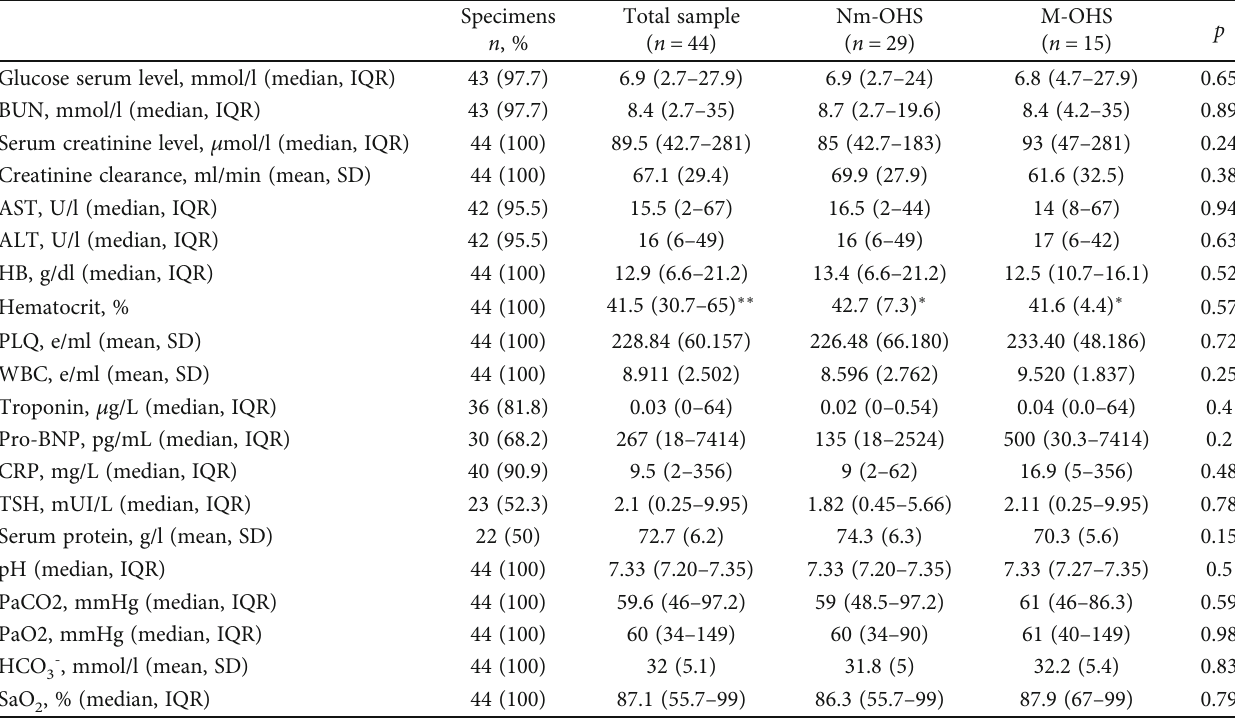
Figure 2: Cardiovascular and metabolic comorbidities in the study sample. Table 2: Laboratory data of patients at